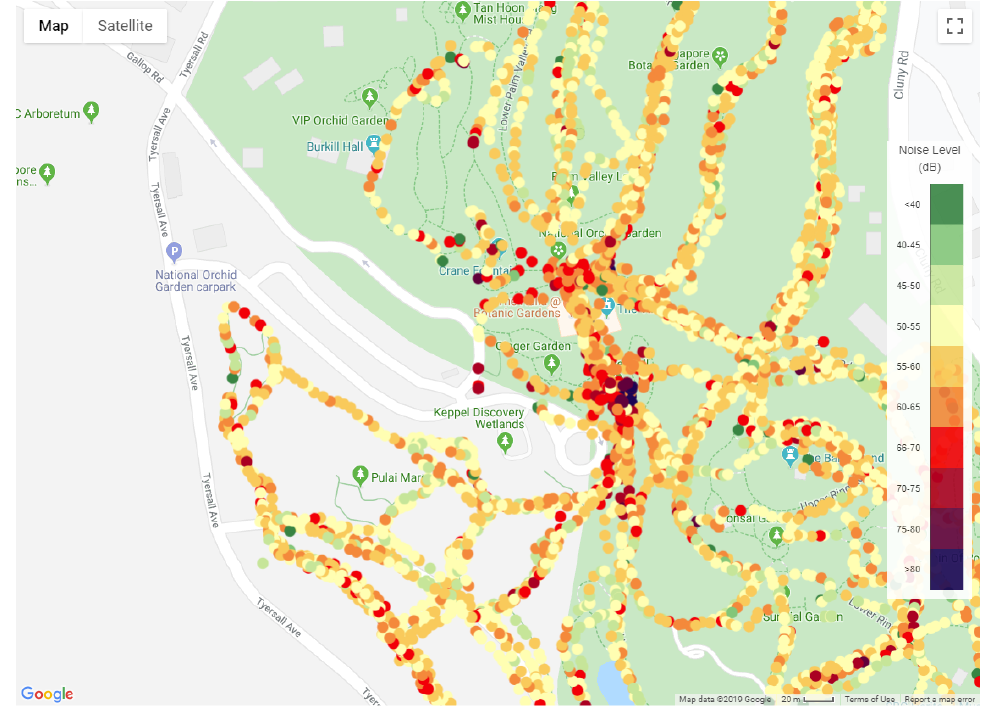
Figure 4: The noise map of the entrance to the National Orchid Centre (enlarged view of the middle portion of Figure 1)